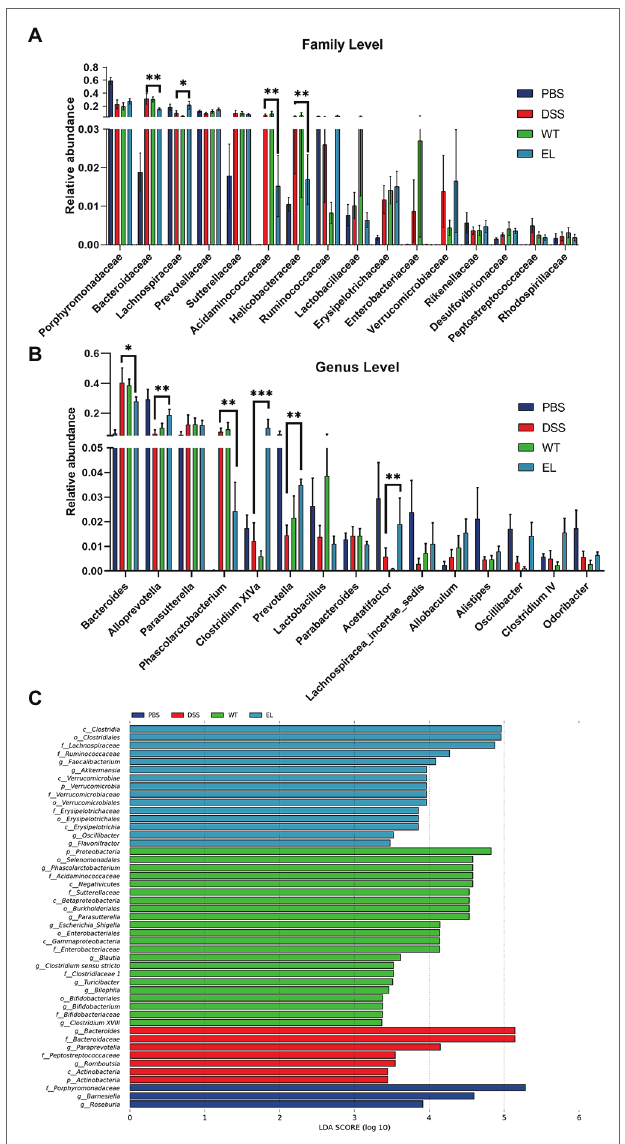
FIGURE 5 | Effect of EcN-Elafin on the bacterial composition in the gut of DSS-induced chronic colitis mice. (A) Relative abundances of a common set of microbial families; (B) Relative abundances of a common set of microbial genera; (C) Differences in microbiota in each group were calculated by LDA effect size (LEfSe). n = 6 per group. Kruskal-Wallis test was used with a statistical significance cutoff of p < 0.05 and the threshold of LDA score is 2. p, phylum; c, class; o, order; f, family; and g: